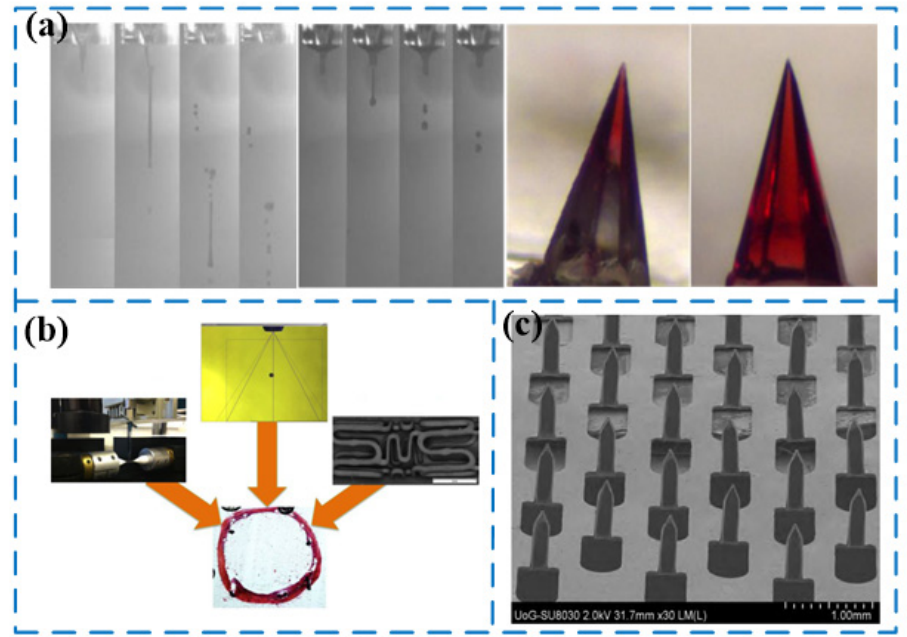
Figure 5. Drug delivery: ( a ) the drug microneedle made by O’Mahony et al. [92], ( b ) the drug mi- croneedle made by Scoutaris et al. [97], and ( c ) the drug microneedles made by Uddin et al. [98].